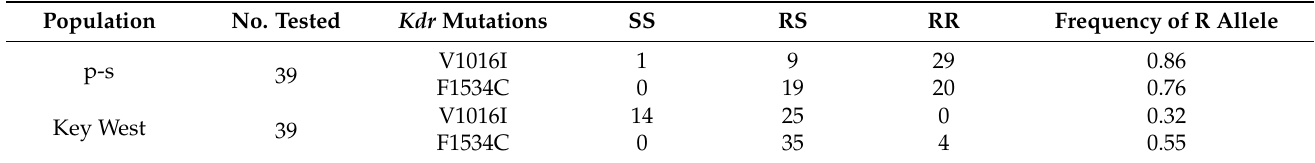
Table 3. Number of mutations in the sodium channel gene in populations of Ae. aegypti